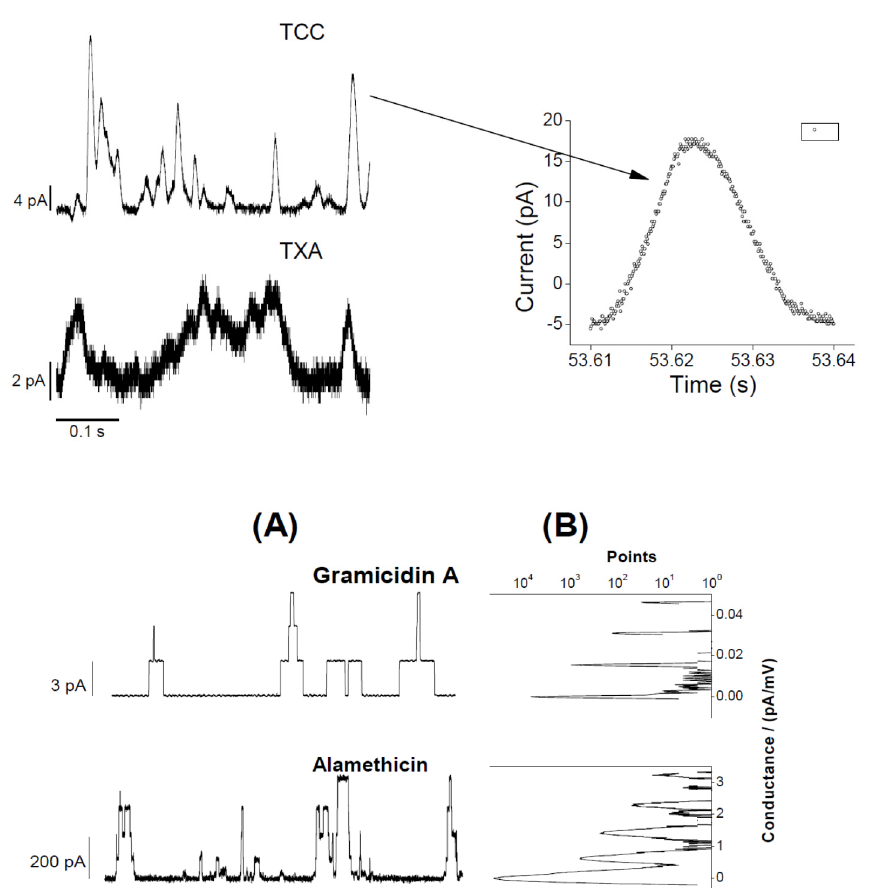
Figure 4. Comparison of two CD TCC and taxol (TXA) pore current traces with peptide (AgA (15) and alamethicim (Alm)) channel currents [9]. AgA (15) is a gramicidin A (gA) analogue having 15 amino acids in its sequence. The upper panel shows triangular-shape conductance events induced by TCC and TXA, both at 90 µ M. pH = 5.7, V = 100 mV, filtered at 20 kHz. A single conductance event (pointed by a right arrow) shows all current points (in Origin 8.5 plot) and suggests for a triangular pattern, so does the pore current change spontaneously with time in both increasing and decreasing directions. The lower panel ( A ) illustrates rectangular-shape conductance events in gA and Alm channels (Ashrafuzzaman et al., 2008). gramicidin A (gA) channel activity was recorded at V = 200 mV and Alm at V = 150 mV and filtered at 2 and 20 kHz, respectively. Current values I gA = 29 ± 2, 113 ± 5, 243 ± 9, and 386 ± 10 pA, respectively, are the discrete current levels 0, 1, 2, 3, . . . , etc. in the Alm channel. ( B ), the point count plots of the current traces through AgA (15) and Alm channels showing peaks at discrete values of conductance. The discreteness in conductance values for the CD pores is missing due to their triangular nature [1,2].